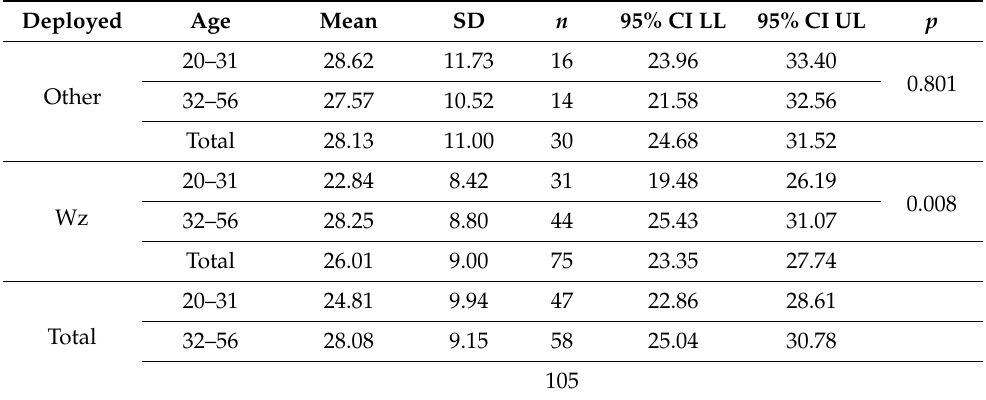
Table 2. Distribution of U.S. Marines across vitamin D categories. No di ff erence in distribution